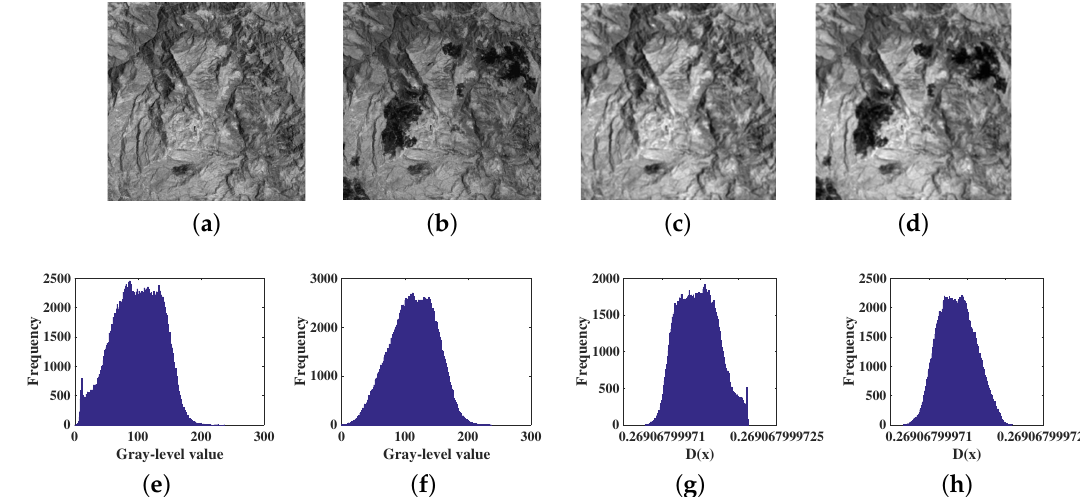
Figure 13. Comparison between original images and feature maps on Mexico data set: ( a ) Original image I 1 , ( b ) Original image I 2 , ( c ) Feature map (estimated probability) F 1 , ( d ) Feature map